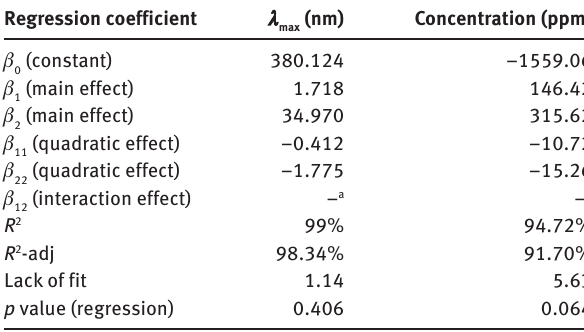
Table 2: Regression coefficients, R 2 , adjusted R 2 (R 2 -adj), and probability values for the final reduced models suggested for synthesis of AuNPs.